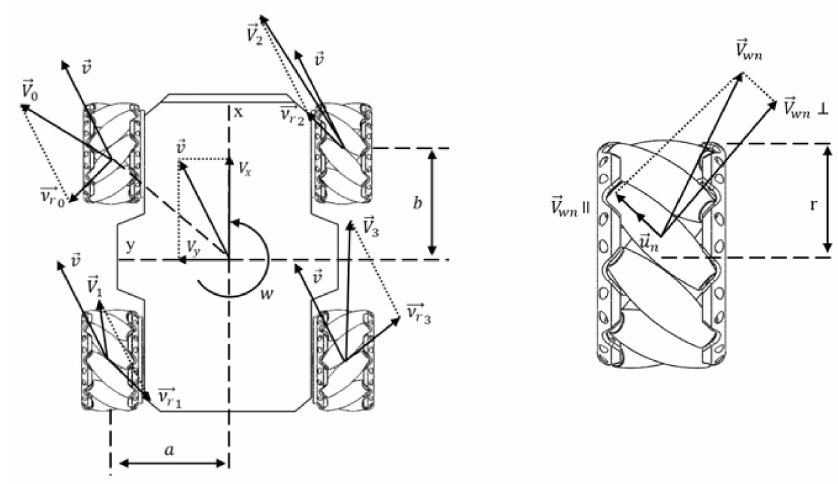
Figure 9. Kinematic analysis of a modular